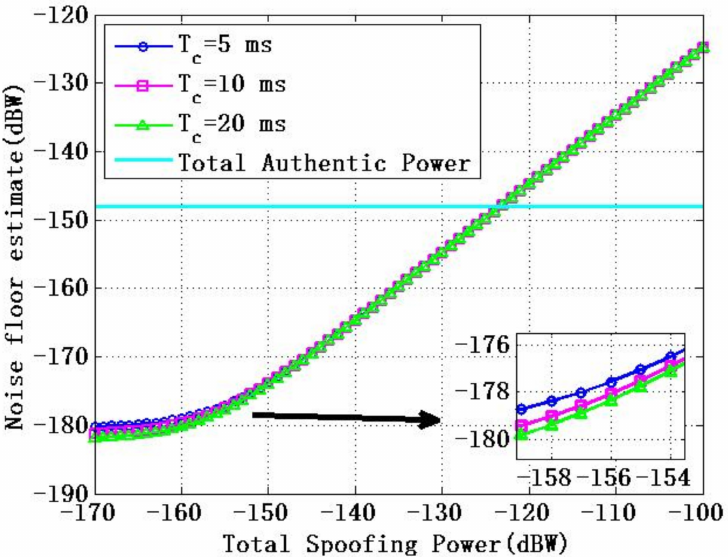
Figure 2. Relationship between total power of spoofing signal and estimation of receiver noise